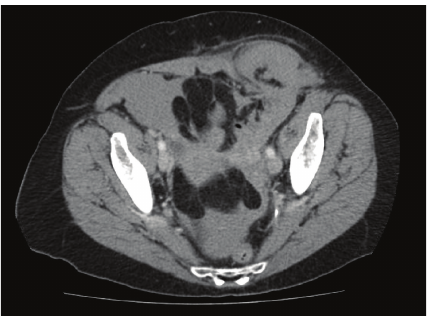
Figure 1: Preoperative noncontrast abdominal CT scan showing a large left indirect inguinal hernia